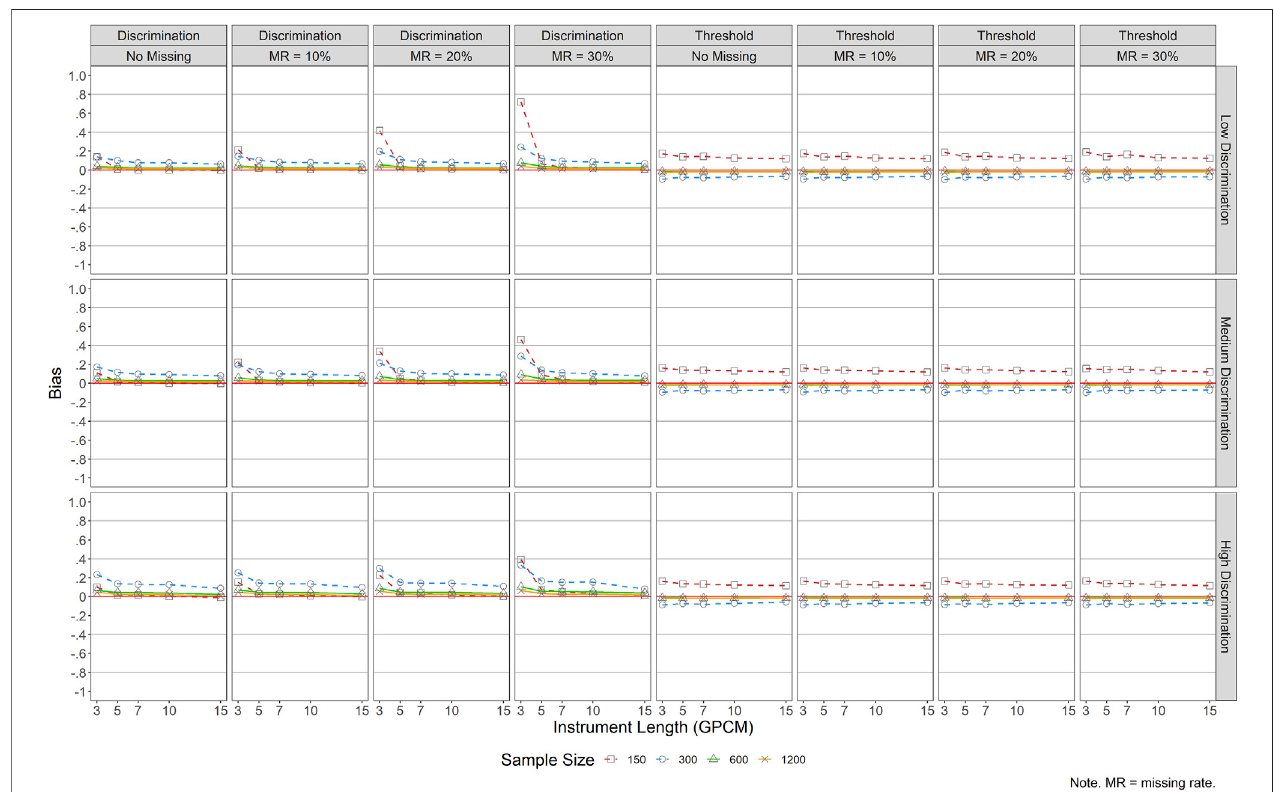
FIGURE 3 | Bias of Item Parameter Estimations for GPCM. Note. MR (cid:1) missing